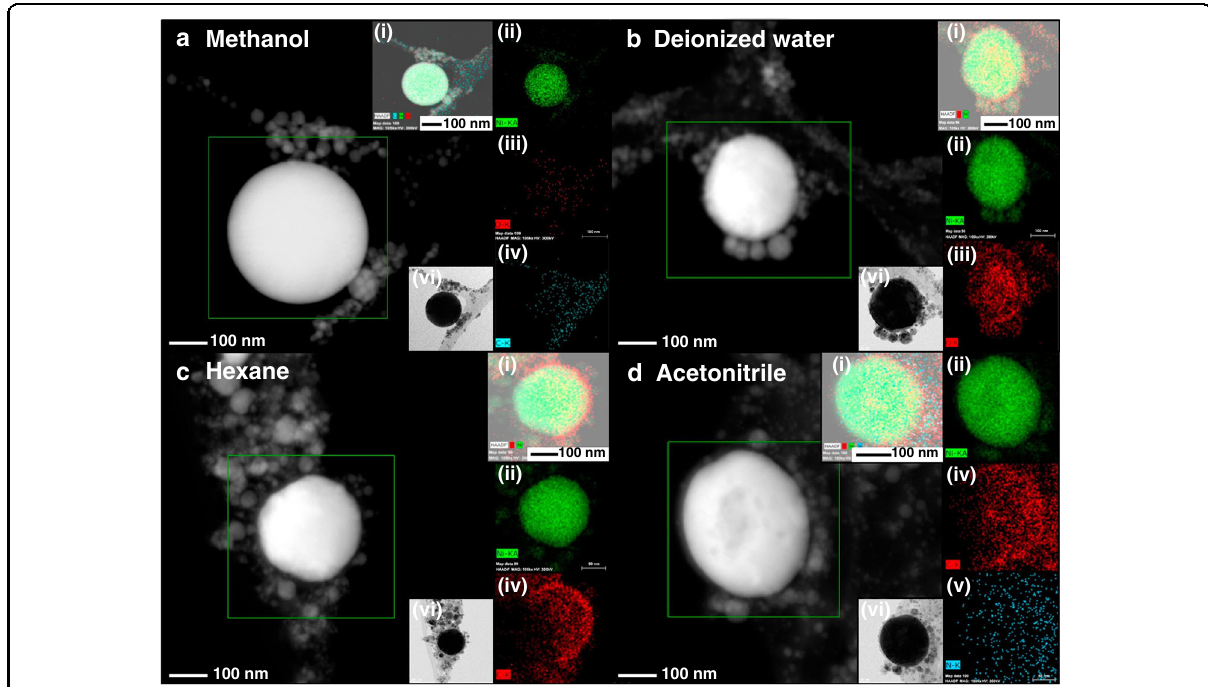
Fig. 10 Elemental mapping images of materials produced by the ablation of the Ni plate in various solvents. a methanol, b DI water, c hexane, and d ACN. The insets show the images of the i overall, ii Ni, iii O, iv C, v N, and vi resulting TEM images 37 . Copyright (2021)